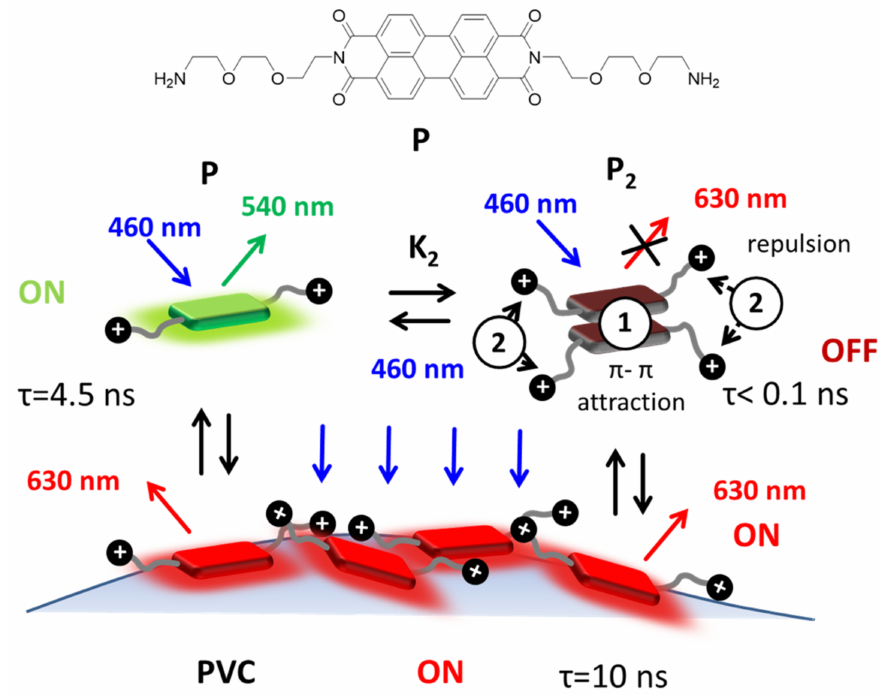
Figure 1. Structure of the fluorescent probe P that includes a central hydrophobic perylene-diimide (PDI) unit and two hydrophilic amino-terminated branches that are protonated in water at pH 7. In neutral water solution, P is, to a large extent, aggregated in the form of very weakly red emitting dimer, P 2 , with very short excited state lifetime τ < 0.1 ns. Upon adsorption on polyvinyl chloride (PVC), P becomes intensely red fluorescent and the excited state lifetime increases to 10 ns. The attractive π – π and repulsive electrostatic interactions between P molecules are schematized as 1 and 2. Adsorption of PVC leads to disaggregation and switch-on the red fluorescence (this mechanism is discussed in detail in the main